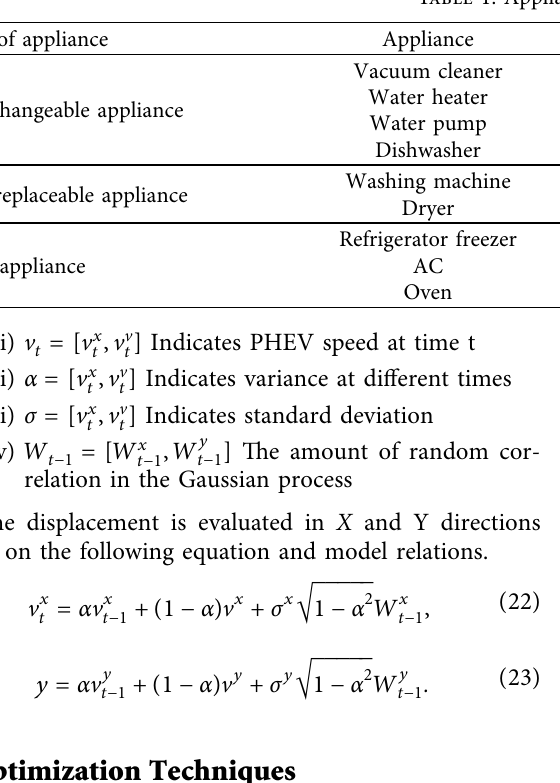
Table 1: Appliance